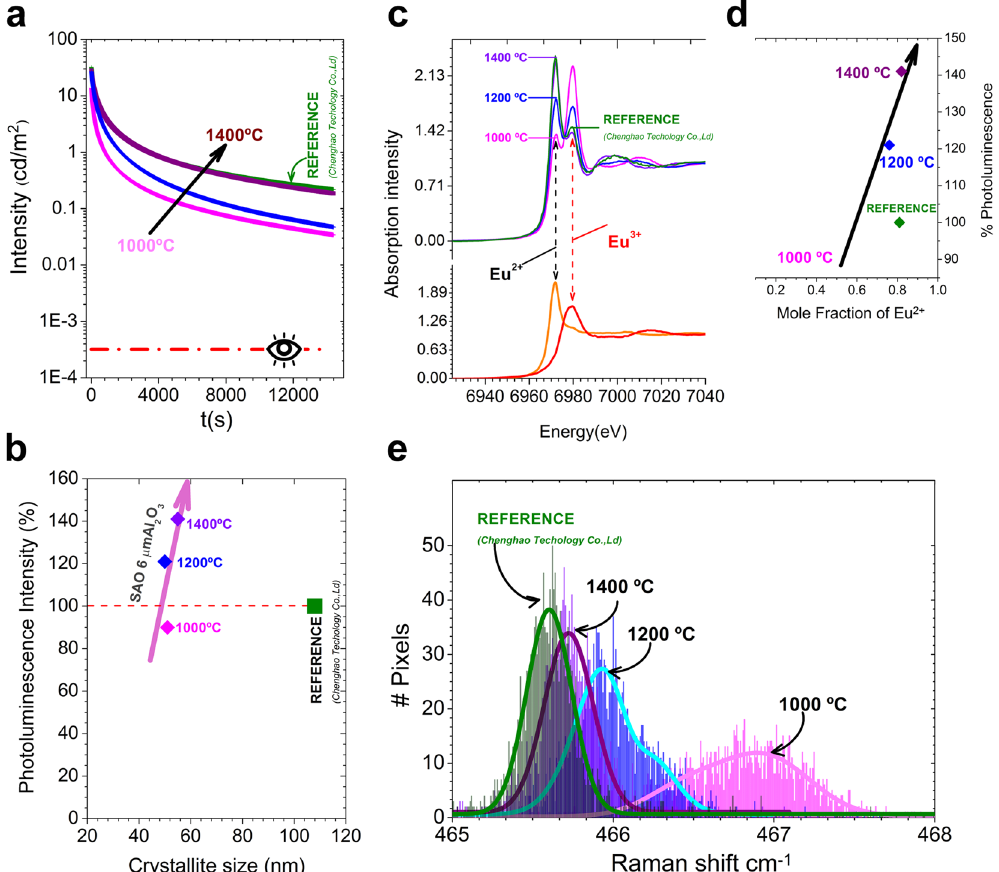
Figure 3. Functional properties can be tuned by post-thermal treatment. ( a ) Afterglow decay curve of SrAl 2 O 4 :Eu, Dy powder synthesized at 1000 (magenta decay curve), 1200 (blue decay curve), and 1400 (purple decay curve) °C for 2 h in 90N 2 -10H 2 atmosphere, employing a salt/SrAl 2 O 4 molar ratio of 3:1, as precursor alumina platelets with an average particle size, d 50 ≈ 6 μ m) and using Al 2 O 3 /SrO molar ratio of 2 compared to the commercial powder (green decay curve) after the light source was cut off, irradiated for 10 min by solar simulator. ( b ) % of photoluminescence intensity tendencies taking as reference the commercial powder as a function of the crystallite size for the initial reference material and the materials synthesized here by means of molten salts referred to as SAO 6 μ m Al 2 O 3 (Al/Sr: 2) synthesized at 1000, 1200 and 1400 °C. ( c ) Top panel: XANES spectra of the powder synthesized at 1000 (magenta spectrum), 1200 (blue spectrum), 1400 °C (purple spectrum) and initial reference material: microparticle SrAl 2 O 4 :Eu, Dy from Jinan Chenghao Technology Co., Ltd (green spectrum). Bottom panel: XANES reference spectra of Eu 2 + (EuI) and Eu 3 + (Eu 2 O 3 ). ( d ) % of photoluminescence intensity of SrAl 2 O 4 :Eu, Dy powder synthesized at 1000 (magenta diamond), 1200 (blue diamond), 1400 °C (purple diamond) and initial reference material (green diamond). As a function of the Eu 2 + fraction. ( e ) Statistic distribution of the Raman shift for O-Al-O Raman mode for of SrAl 2 O 4 :Eu, Dy powder synthesized at 1000 (magenta distribution), 1200 (blue distribution), 1400 °C (purple distribution) and initial reference material (green